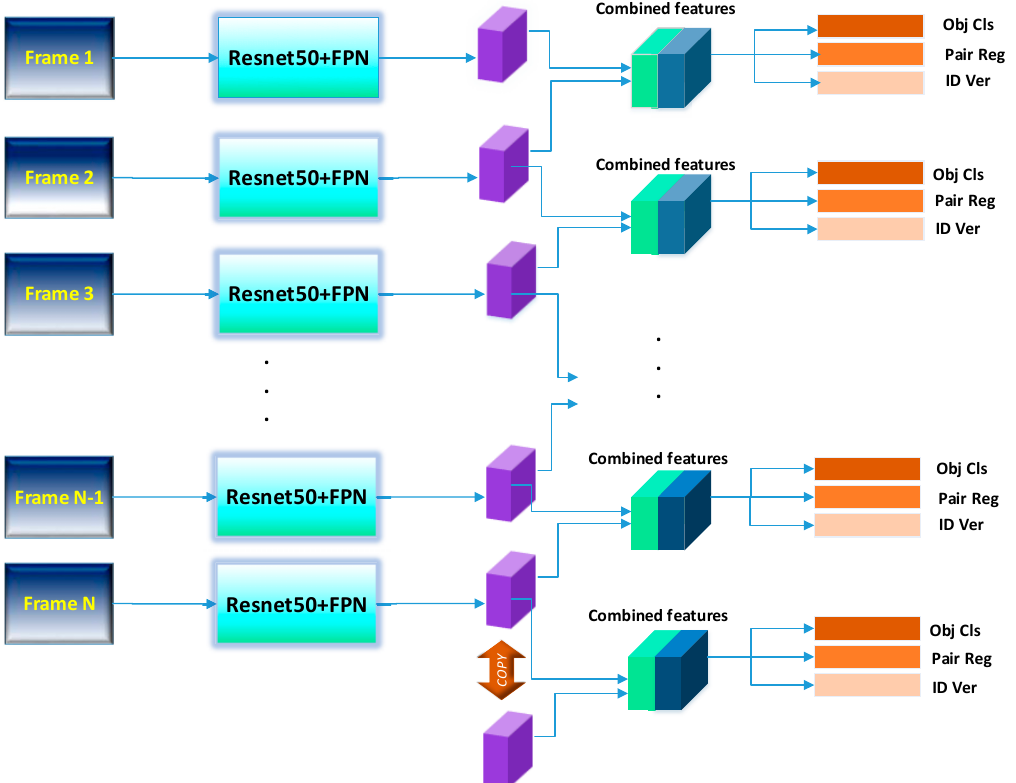
Figure 3. The Memory Sharing Mechanism (MSM) shows the features extracted from each frame (not from the first one) using Resnet-50 with FPN. These features are used for current and even future nodes. The computation cost is alleviated by using the last frame N to avoid its duplicate copy in the case of N + 1.